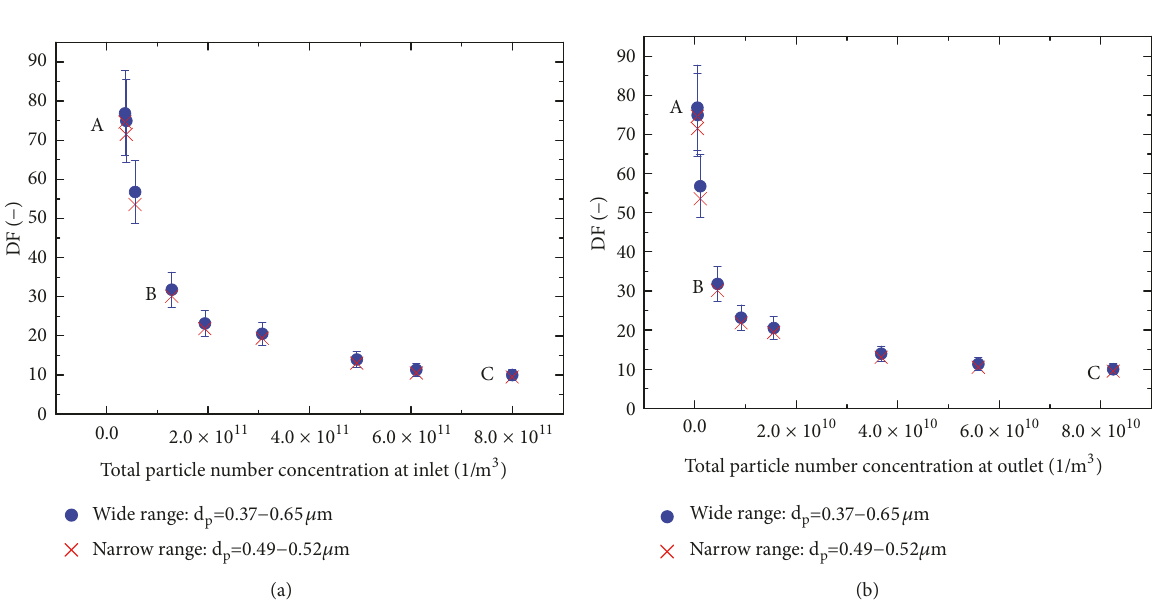
Figure 3: DF derived from WELAS against total particle number concentration (a) at inlet and (b) at outlet.